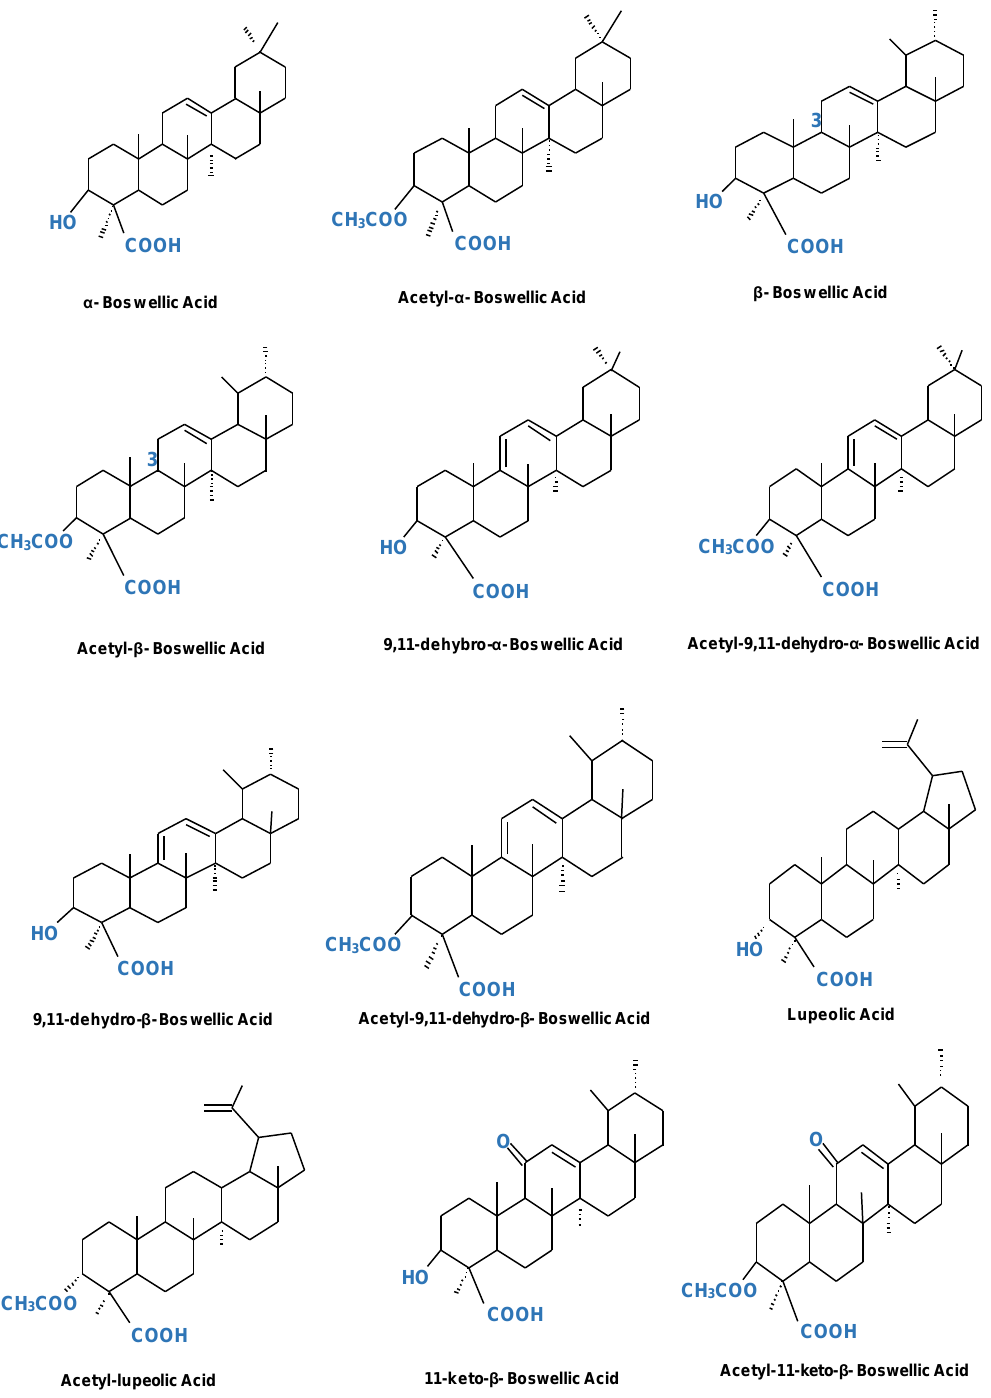
ff erent triterpenic acids of the Boswellia Figure 2. Structure of different triterpenic acids of the Boswellia species. Figure 2. Structure of di